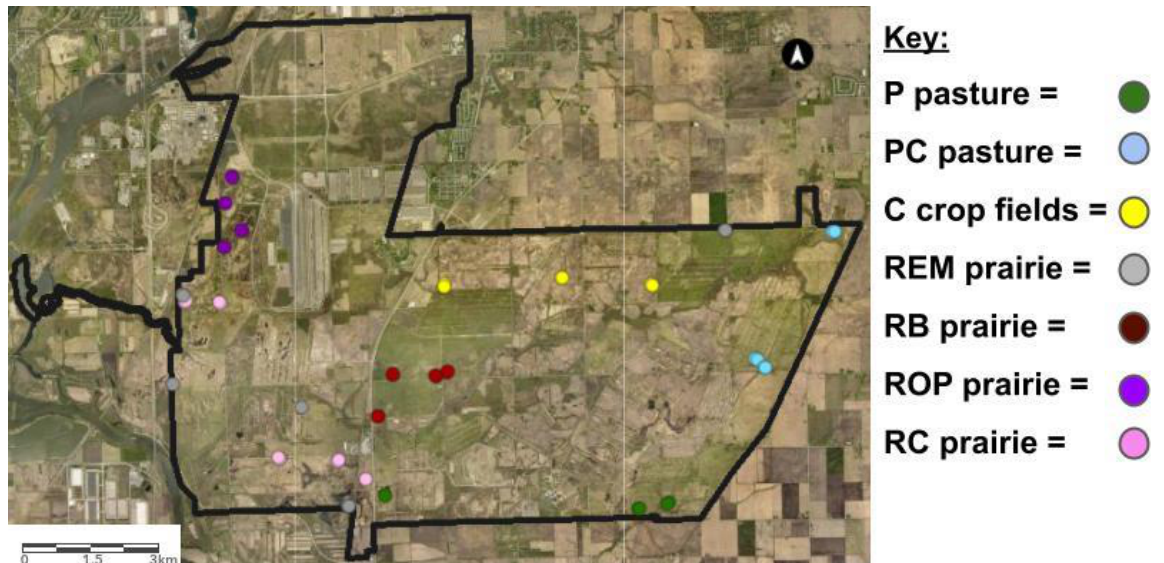
Figure 1. Aerial photograph of Midewin National Tallgrass Prairie. The heavy black line indicates the boundary of the former Joliet Army Ammunition Plant. Land-use histories are cow pasture (P), cow pasture converted from row crop (PC), row crop fields (C), remnant prairie (REM), bison prairie restored from P and PC pasture (RB), prairie restored from old pasture (ROP), and prairie restored from row crop (RC).